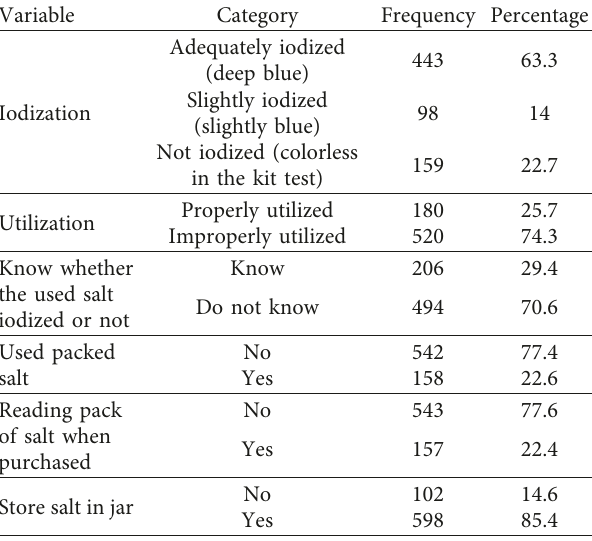
Table 3: Availability and utilization of adequately iodized salt at the household level in Western Amhara, Ethiopia, 2018 ( N �